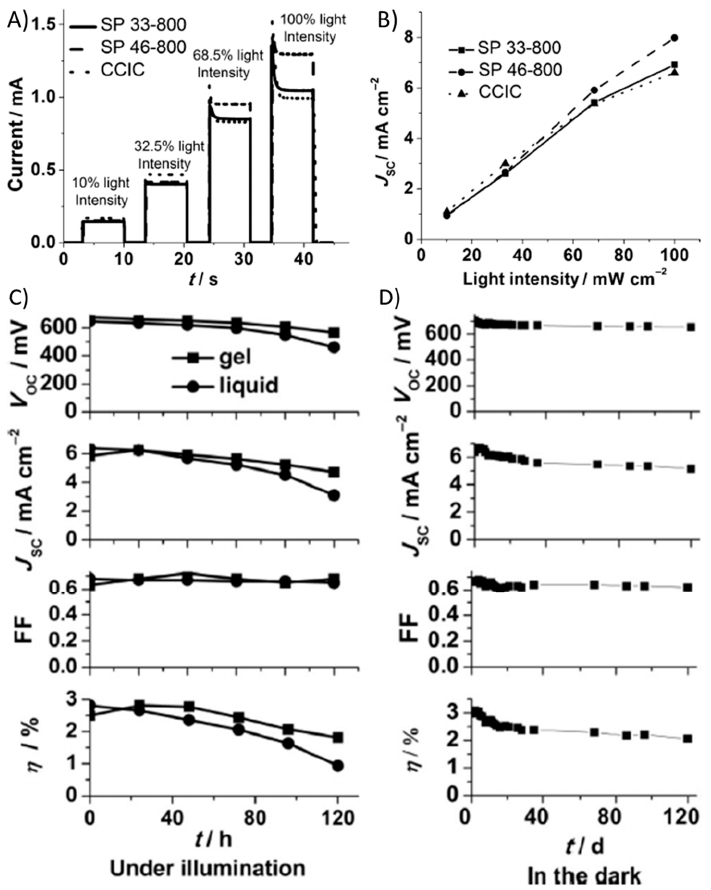
Figure 8. ( A ) Photocurrent transient measurements on DSCs assembled with one of three scattering layers on the different working electrodes. The illumination on/off ratio was fixed at two, which means that the cells were illuminated for 7 s following 3.5 s without illumination. ( B ) Dependence of J sc on light intensity for the three DSCs. ( C ) Performance parameters comparing the stability of the aqueous gel and liquid DSCs under one sun illumination and ( D ) when stored in the dark. Adapted and reprinted with permission from [97].